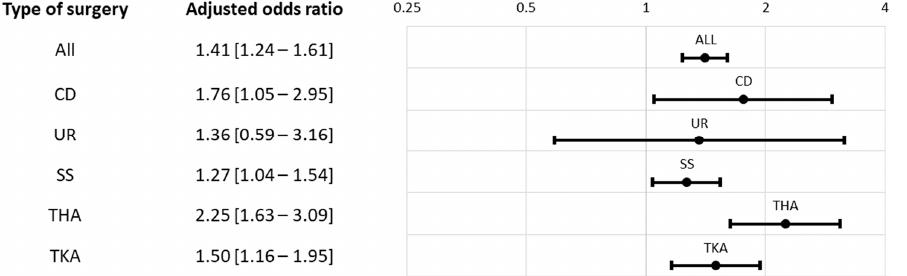
Figure 2. Adjusted odds ratio of post-90-day opioid Rx for index high MME vs. low MME. Abbre- viations: CD, cesarean delivery; THA, total hip arthroplasty; TKA, total knee arthroplasty; SS, spine surgery; UR, hysterectomy (uterus removal).